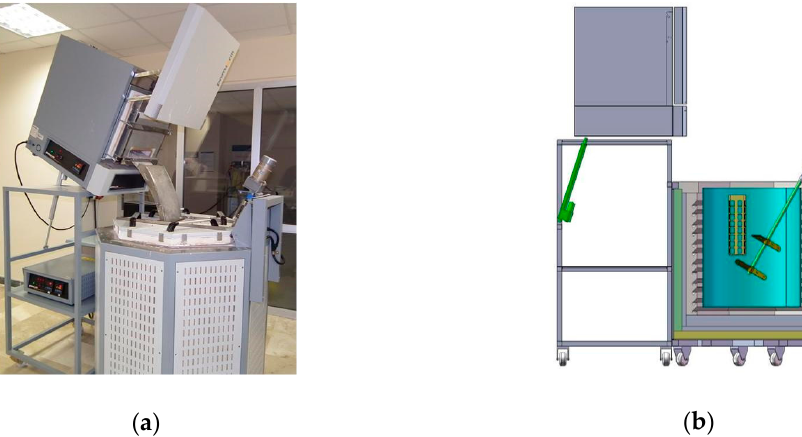
Figure 1. ( a ) Optical (1000×) and ( b ) SEM (5000×) microstructural images of the RHA plate showing its tempered martensite structure in the as-received condition.